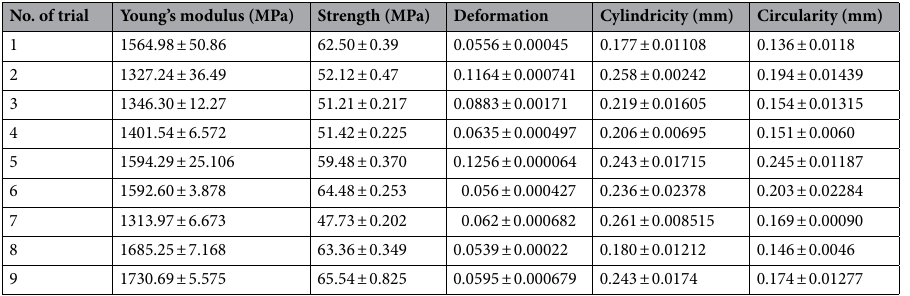
Table 4. Measured values of responses.